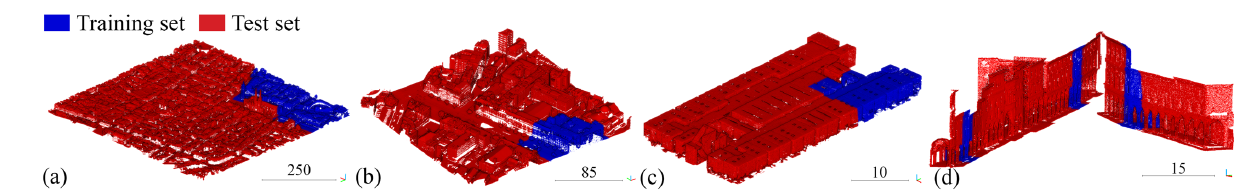
Figure 2. Training and test sets for the four case studies: Bordeaux (a), Dublin (b), S3DIS (c), Bologna (d).